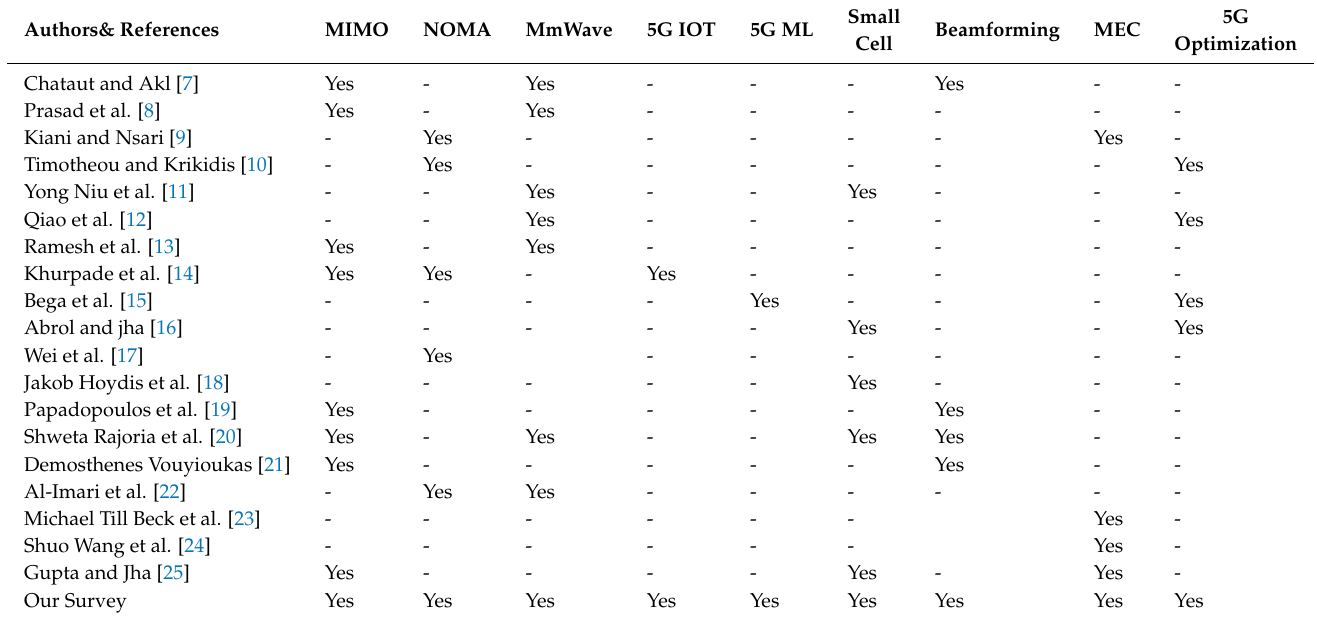
Table 3. A comparative overview of existing surveys on different technologies of 5G